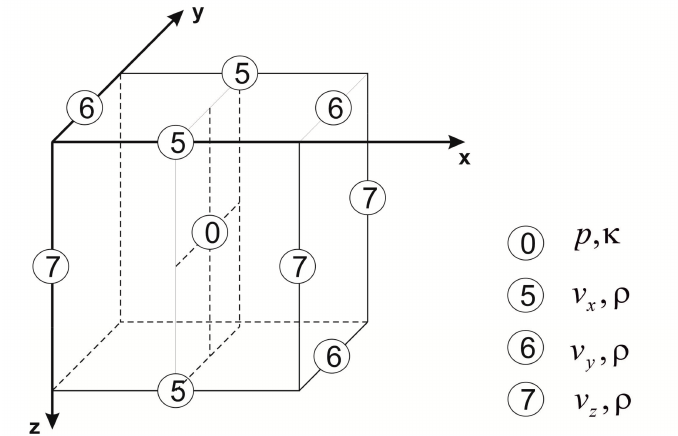
Figure 2. The layout of a finite di ff erence grid cell for the staggered grid formulation in elastic media. The node numbers define the locations of stress components, elastic parameters and density.